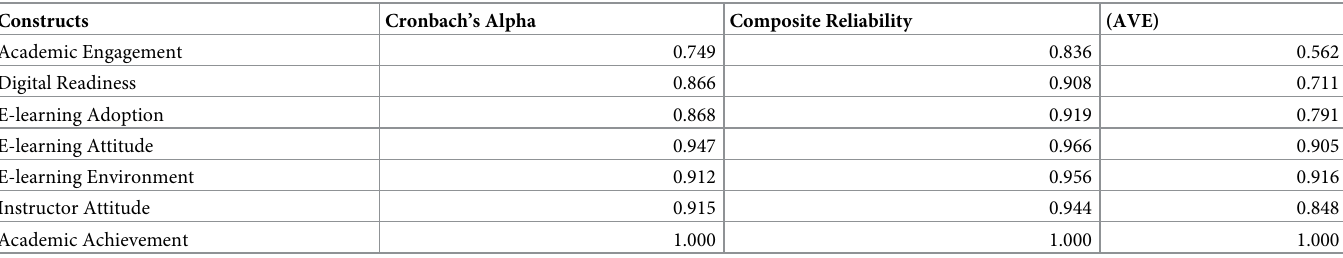
Table 2. Cronbach’s alpha, composite reliability, and average variance